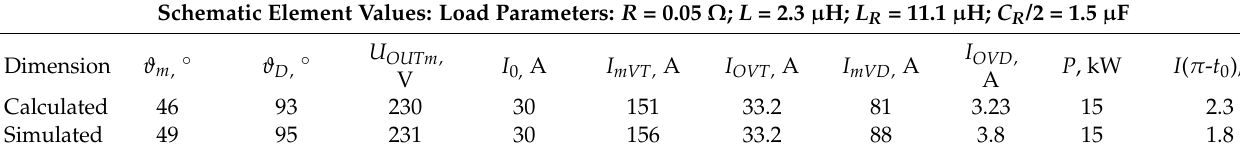
Table 3. Half-bridge RI with ED and split resonant capacitor: design and computer simulation results.